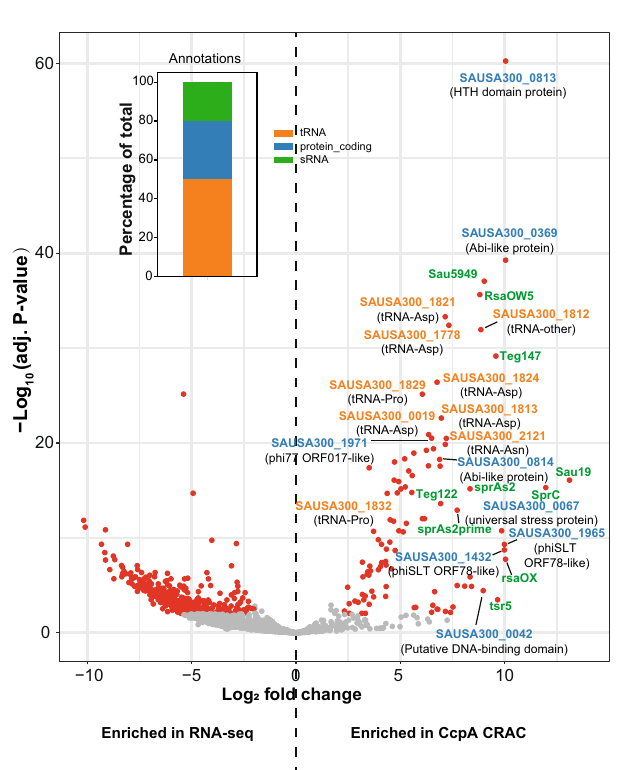
Fig. 4 CcpA CRAC data are highly enriched for tRNAs, mRNAs and sRNAs. Volcano plot showing genes that are enriched in the CcpA CRAC data (right half of the volcano plot) relative to RNA expression levels obtained from RNA-seq data (left half of the volcano plot). For several transcripts that were highly enriched in the CRAC data we included the gene names. Gene names coloured orange encode for tRNAs; Blue: mRNAs; Green: sRNAs. The bar plot embedded in the volcano plot the percentage of genes enriched in the CcpA CRAC data that map to tRNAs, sRNA and mRNAs. Benjamini and Hochberg adjusted P values were calculated using DESeq2 28 for six CRAC samples (two independent biological and three technical replicates each) to three biological replicate RNA-seq data sets generated from cells that were incubated with LPM pH 7.5 medium for 15 min. Supplementary Data 5: WT vs Δ ccpA ). These changes in gene expression could largely be restored by complementing the Δ ccpA with a plasmid containing the WT CcpA (Fig. 8a and Supple- mentary Data 5: WT vs Δ ccpA + pCN33-P tufA :: ccpA /com- plemented strain). To validate the results of the differential expression analyses, we performed Northern blot and RT-qPCR